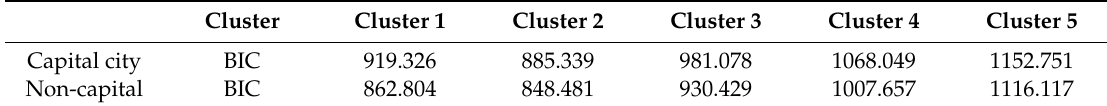
Table 5. The Bayesian Information Criteria (BIC)